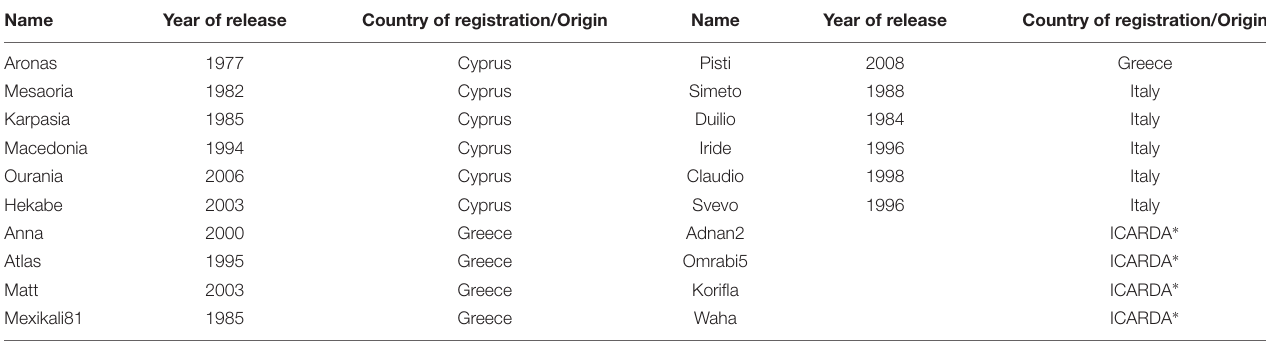
TABLE 1 | List of the durum wheat varieties used in the present